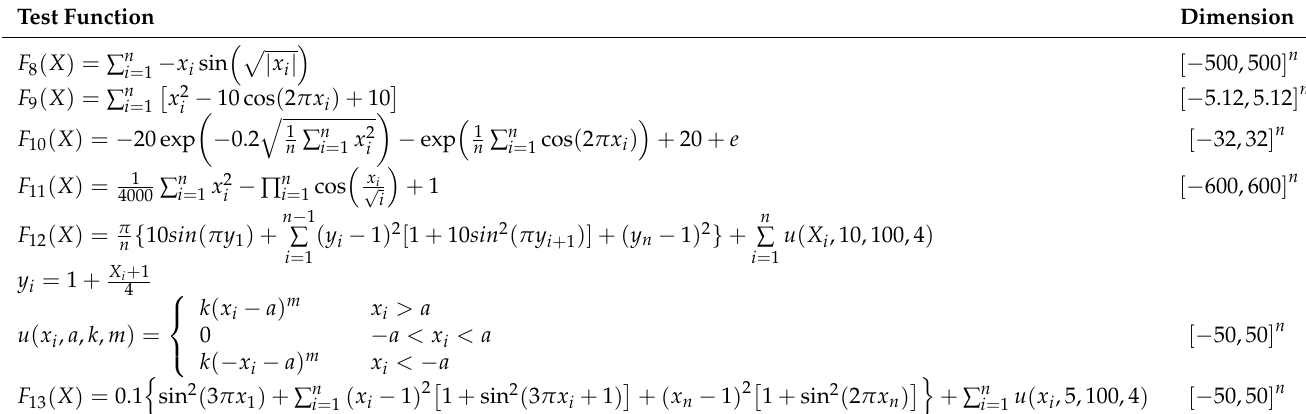
Table 2. Multimodal test